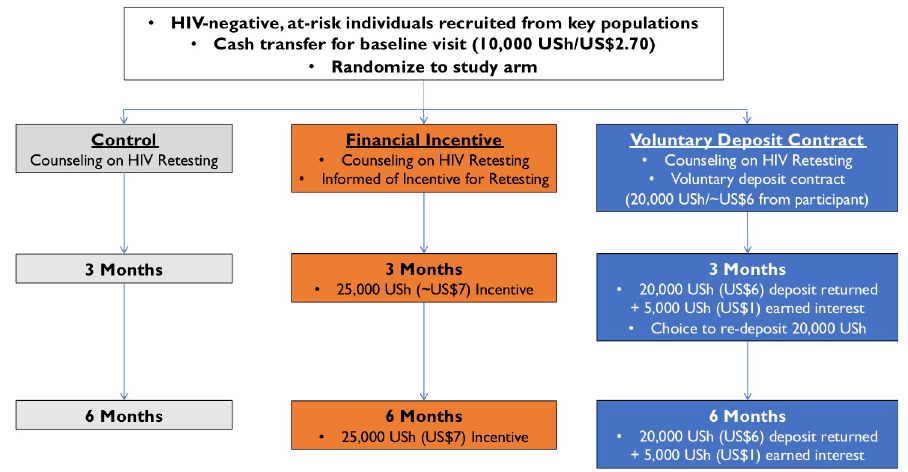
Fig 1. Randomized controlled trial design and study